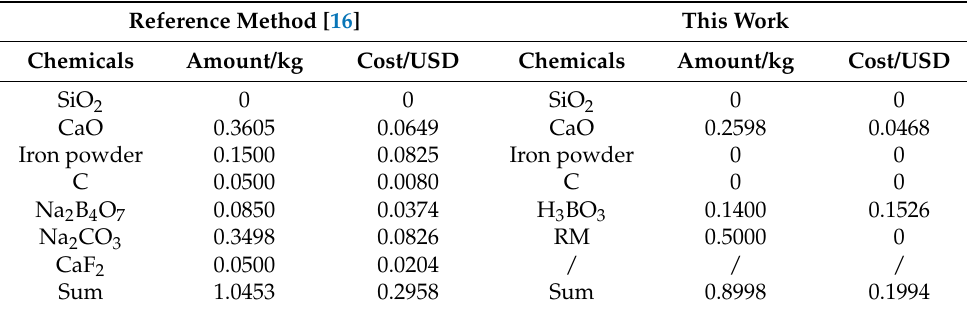
Table 4. The comparison of cost of disposing 1 kg of